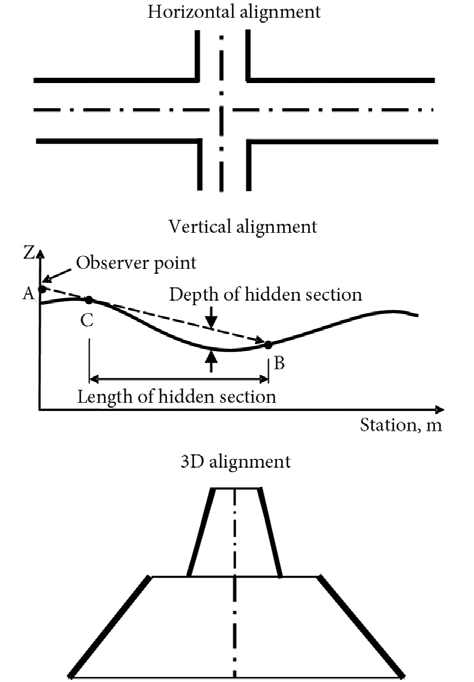
Fig. 1. Hidden dip in an intersection